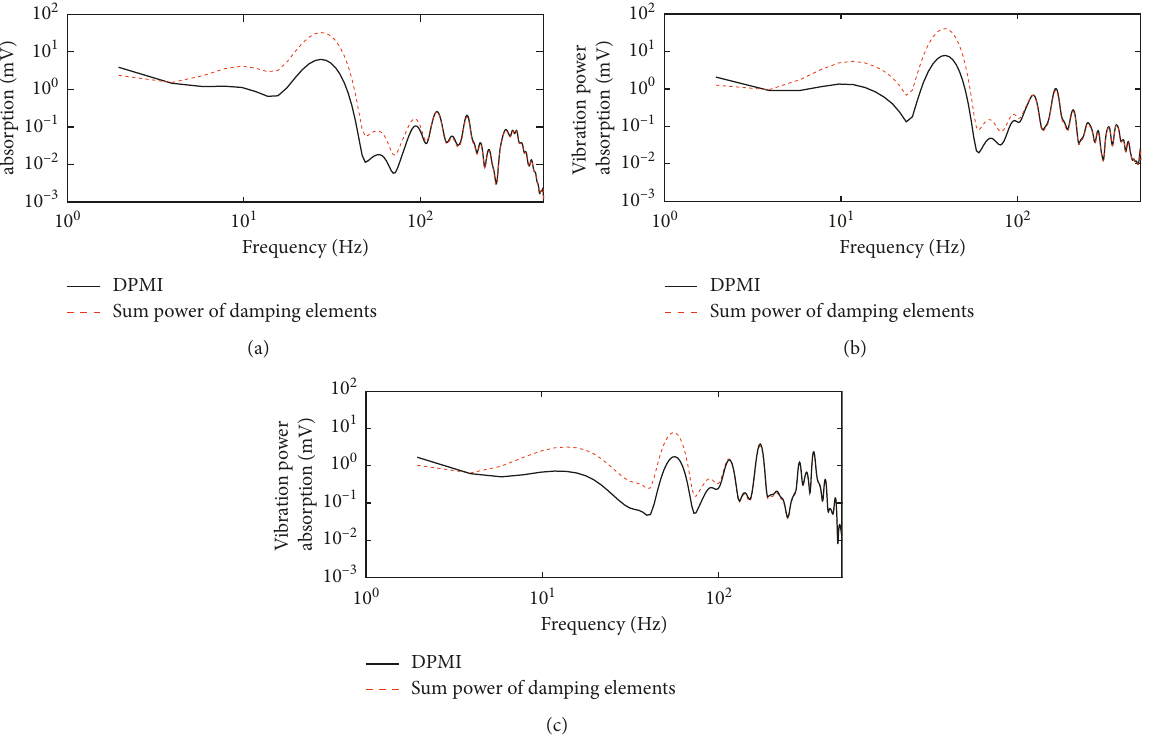
Figure 6: VPA at different rotating speeds: (a) 3400r/min; (b) 5000r/min; (c)